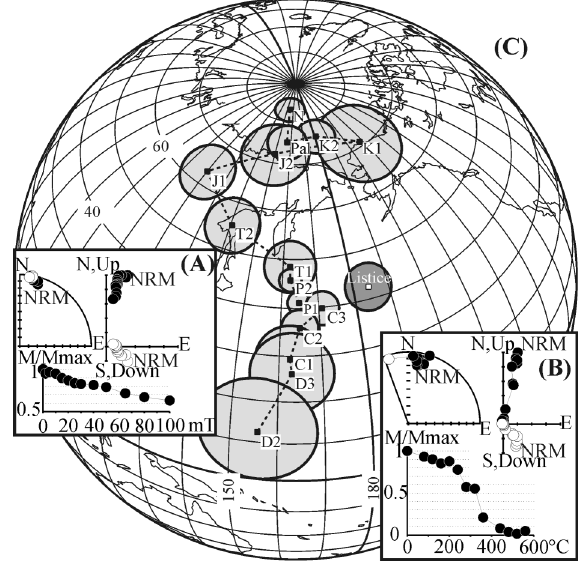
Fig. 3. Examples of ( A ) AF- and ( B ) TH-demagnetization, and the ( C ) apparent polar wander path for a stable Europe based on Besse & Courtillot (1991), Krs & Pruner (1995) including VGP from ChRM of this study in darker grey. NRM marks the natural remanent magnetization; D, C, P, T, J, K and Pal symbolize the Devonian, Carboniferous, Permian, Triassic, Jurassic, Cretaceous and Palaeogene, respectively.